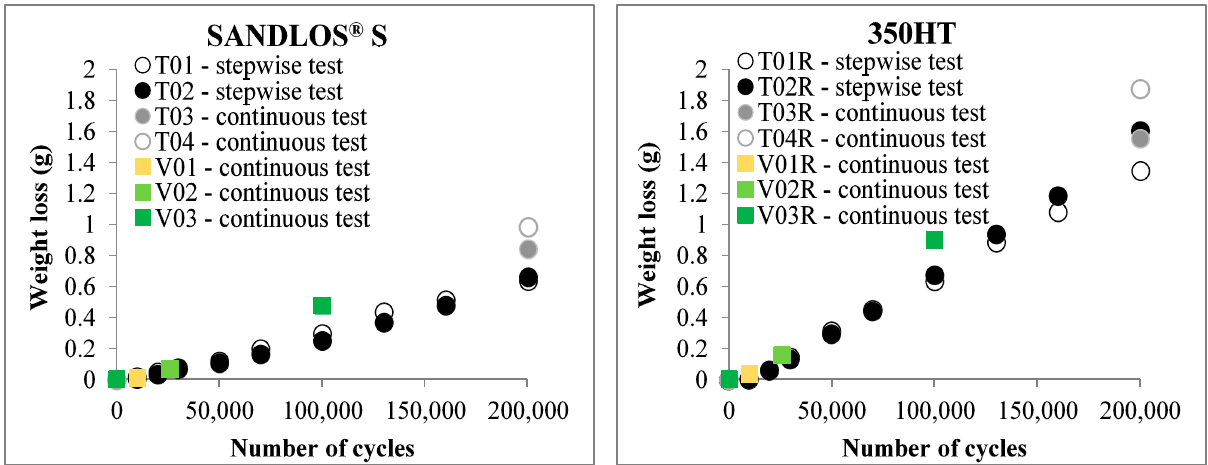
Figure 12. Weight loss of the wheel and rail discs in validations tests and comparison with training tests.